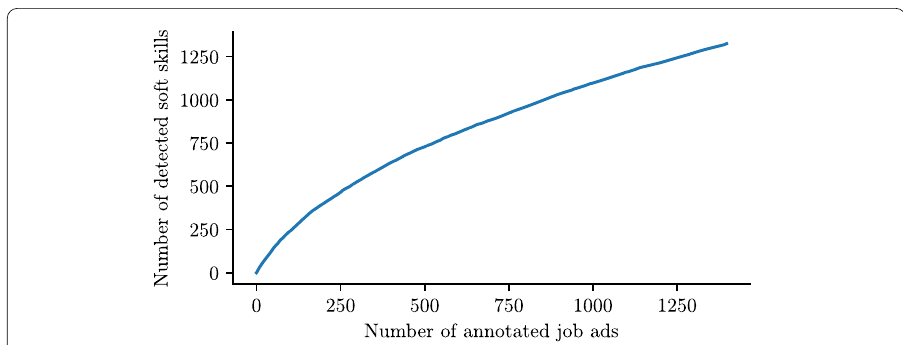
Figure 2 The cumulative number of discovered soft skills as function of annotated job ads. The rate of discovered soft skills slows down towards the end of our data collection. At the end, the newly discovered skills are mostly typos and other phrases unrelated to soft skills. The final, manually refined list consists of 948 unique soft